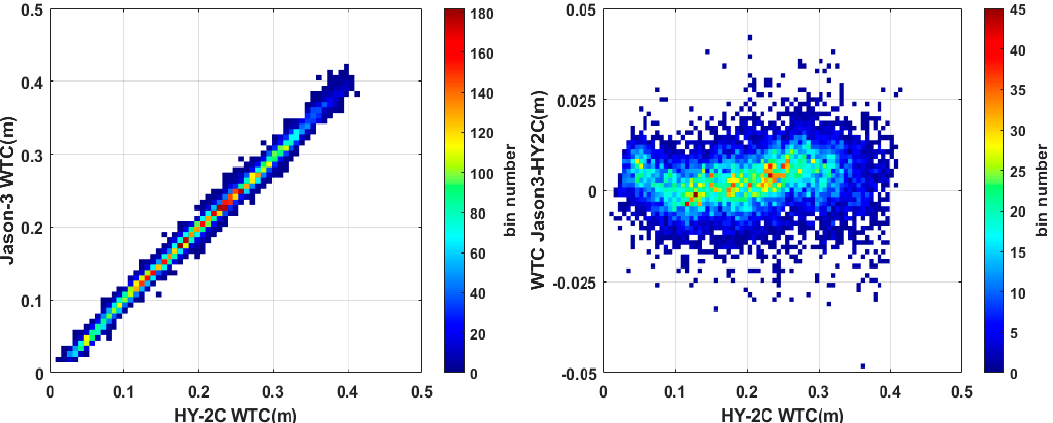
Figure 4. ( Left panel) WTC of HY-2C versus WTC of Jason-3; ( Right panel) WTC of HY-2C versus WTC differences between HY-2C and Jason-3. Table 2. Statistical characteristics of comparison between HY-2C WTC and other WTC methods.